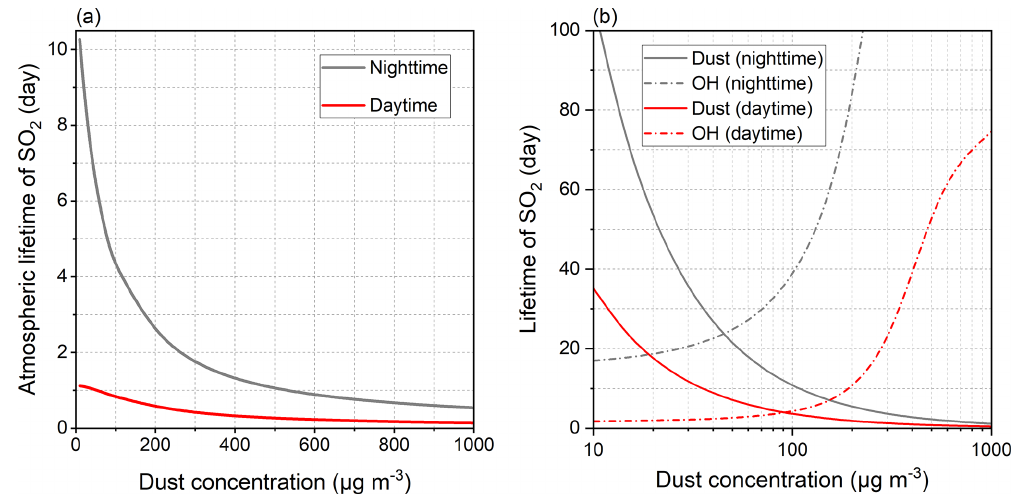
Figure 10. Sensitivity tests of SO 2 lifetime to dust concentration. (a) Atmospheric lifetime of SO 2 induced by all the studied pathways varying with dust concentration. (b) Comparison between the SO 2 lifetimes ascribed to the dust heterogeneous pathway and OH-initiated gas-phase